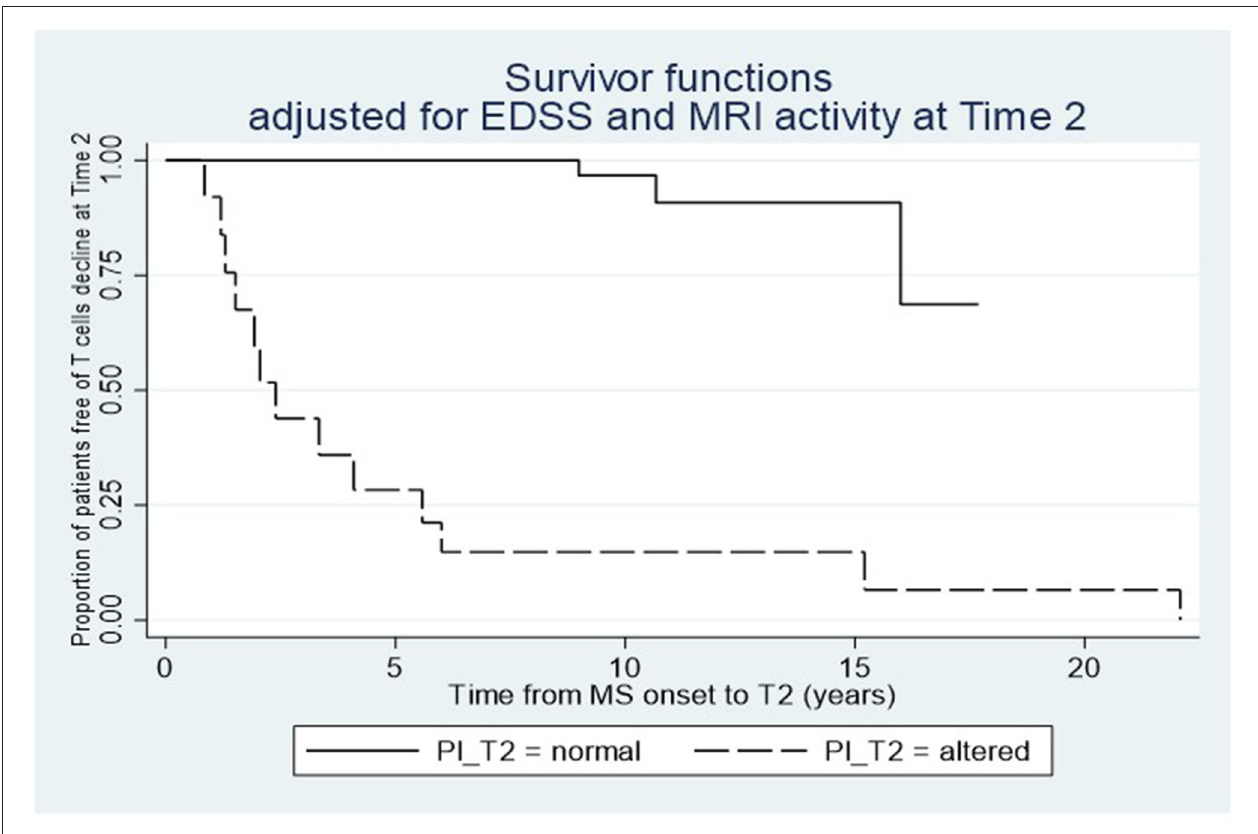
FIGURE 3 | Relationship between the dynamics of circulating CD161 + CD8 + T cells after dimethylfumarate therapy and the IP changes at T2. Cox proportional-hazard estimates show that the T-cell subset drop is higher in patients with IP alterations compared to those with normal IP at